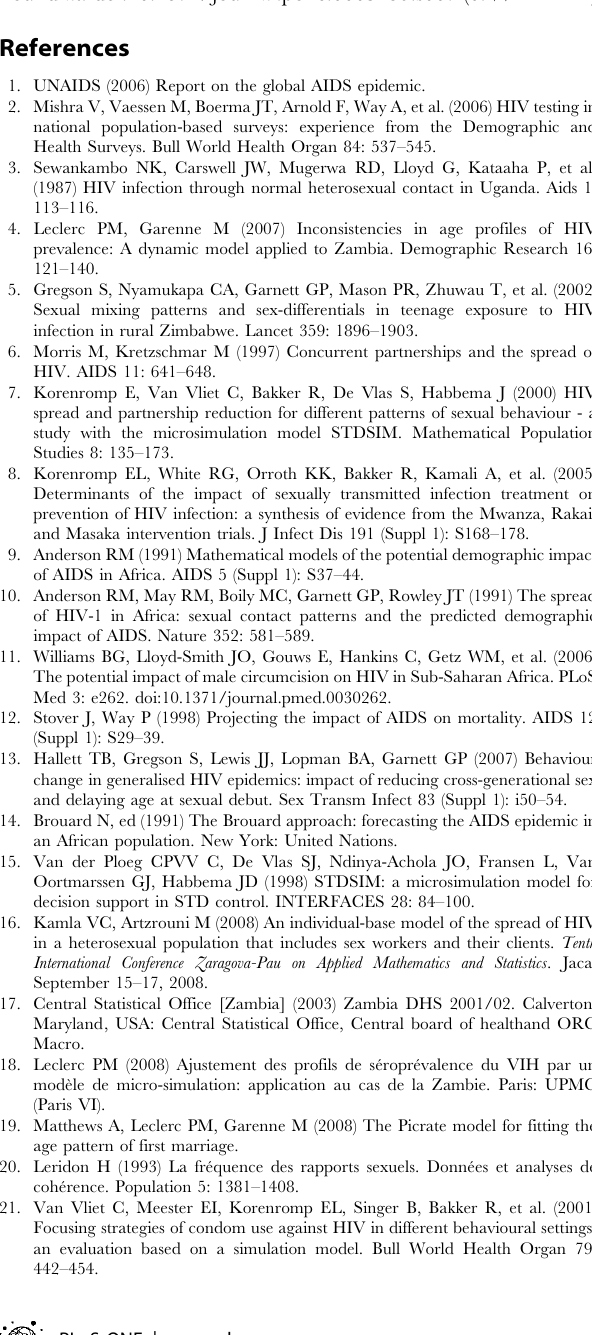
Figure S6 Bivariate gamma distribution of age of partners, premarital relationship. Figure S7 Bivariate gamma distribution of age of partners, extra- or post-marital